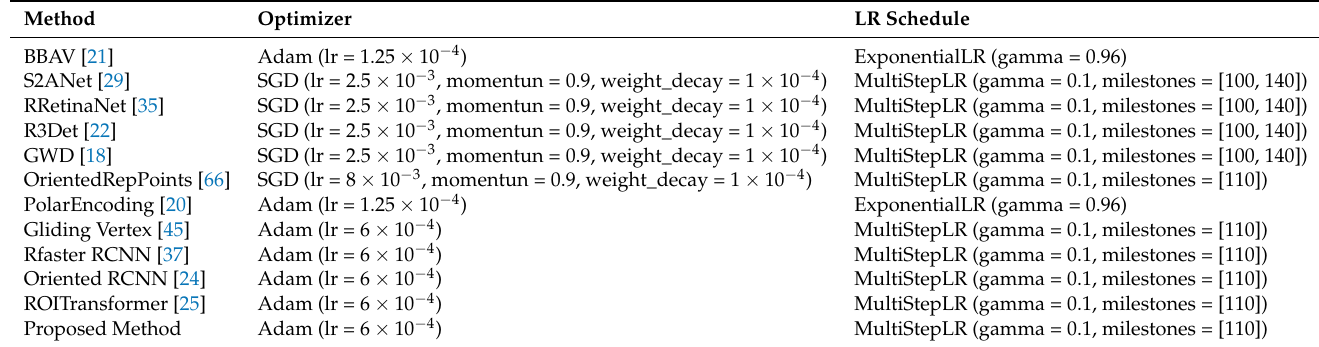
Table 6. Training details for different